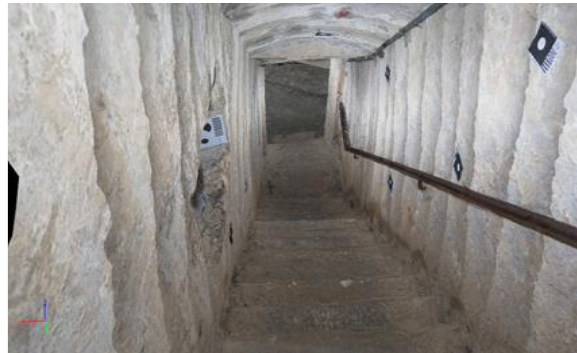
Figure 16: Result of 3D reconstruction of stairs using only front- captured photographs.